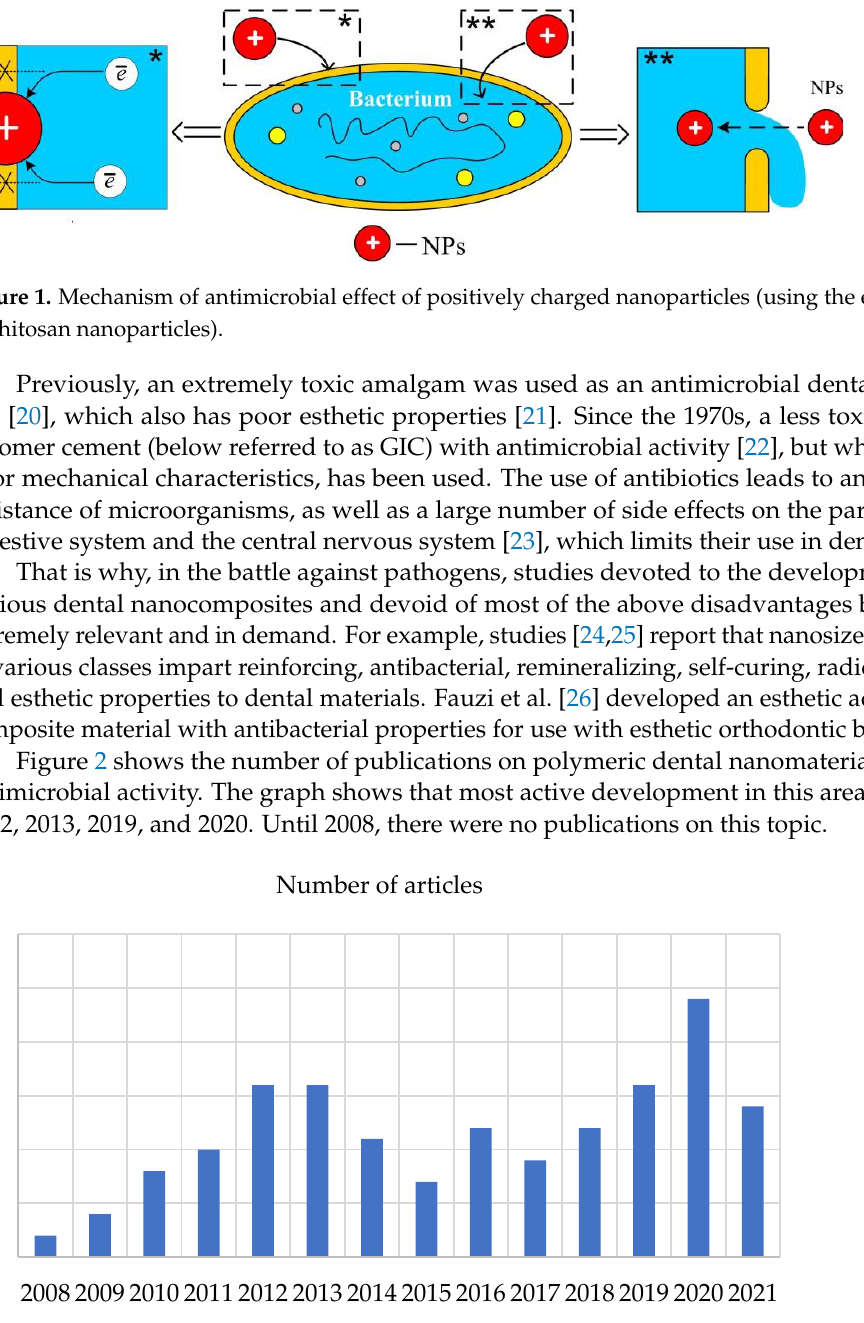
Figure 2. Number of articles on the antimicrobial activity of polymeric nanomaterials for dental applications (PubMed